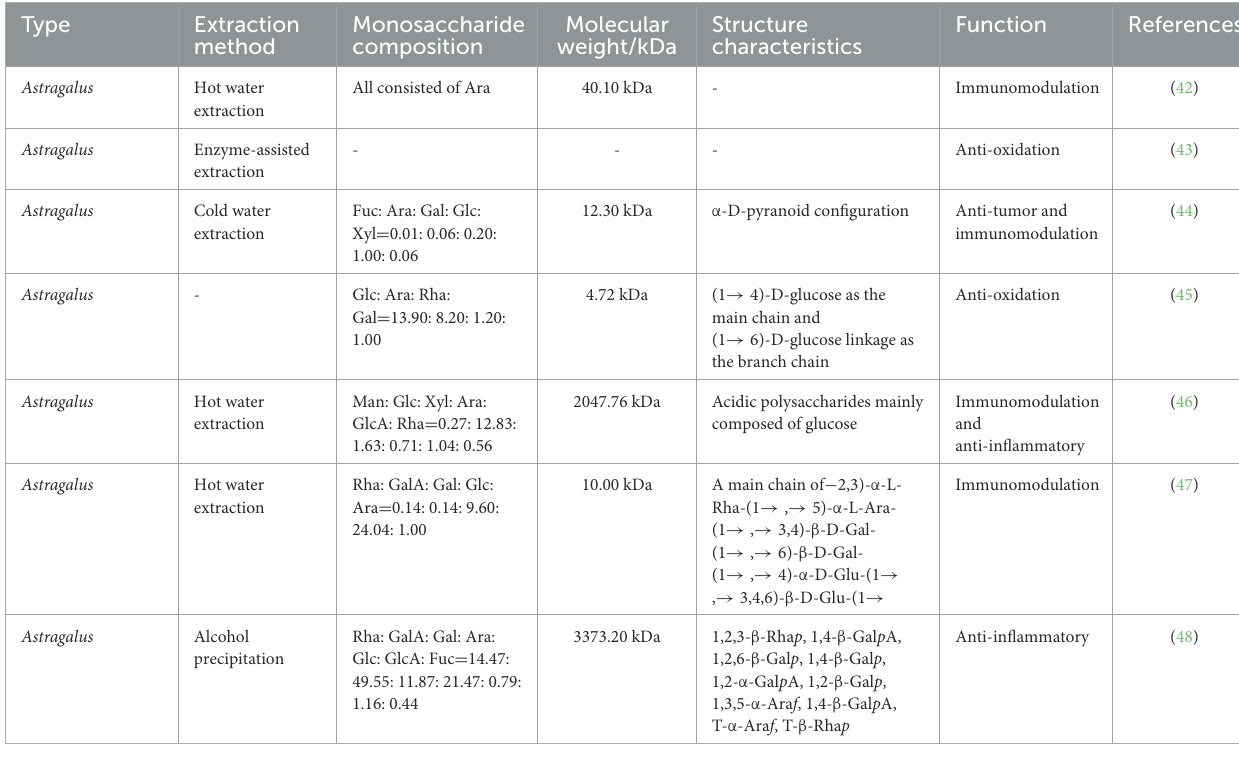
TABLE 2 Structure and structure-activity-relationship of polysaccharide from Astragalus .